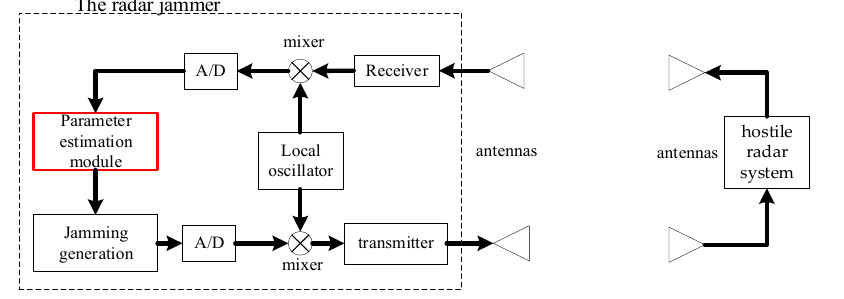
Figure 1. Principle of the radar jammer.